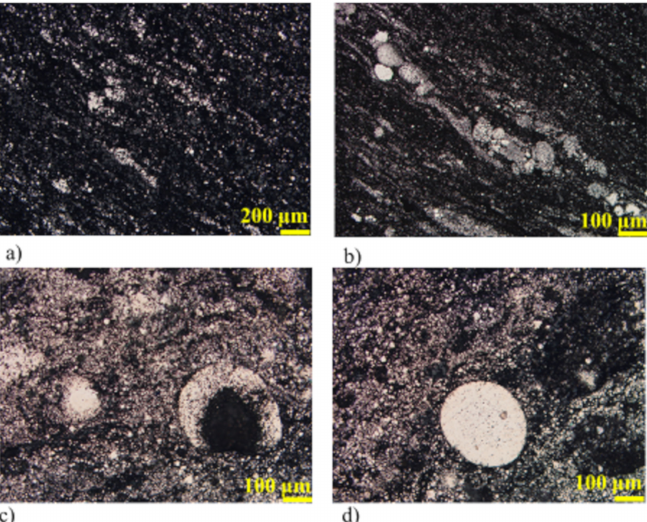
Figure 4. Photomicrographs under reflected light; ( a , b ): fine grained pyrite disseminated in black shale matrix; ( c , d ): pyrite spheres within a pyritic black shale